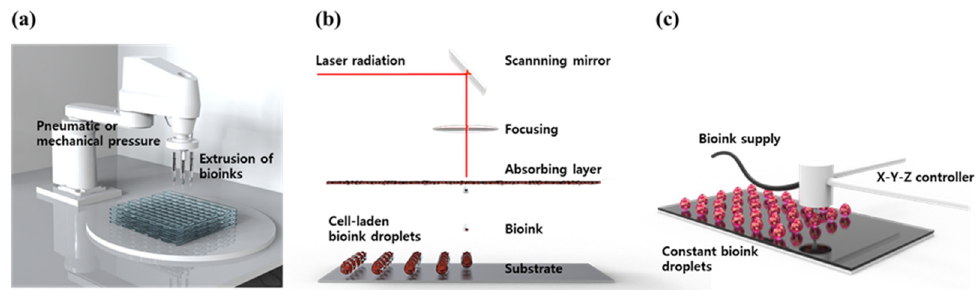
Figure 3. Schematic diagram of common 3D bioprinting methods. ( a ) EBB, ( b ) LAB, and ( c ) DBB.